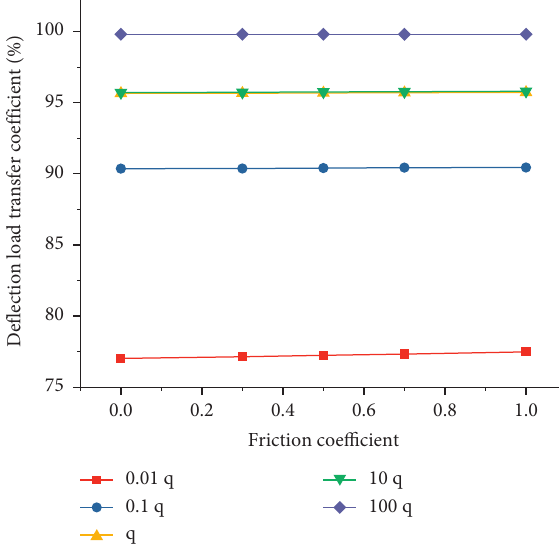
Figure 12: Variation of deflection load transfer coefficient with respect to friction coefficient under different values of spring stiffness.